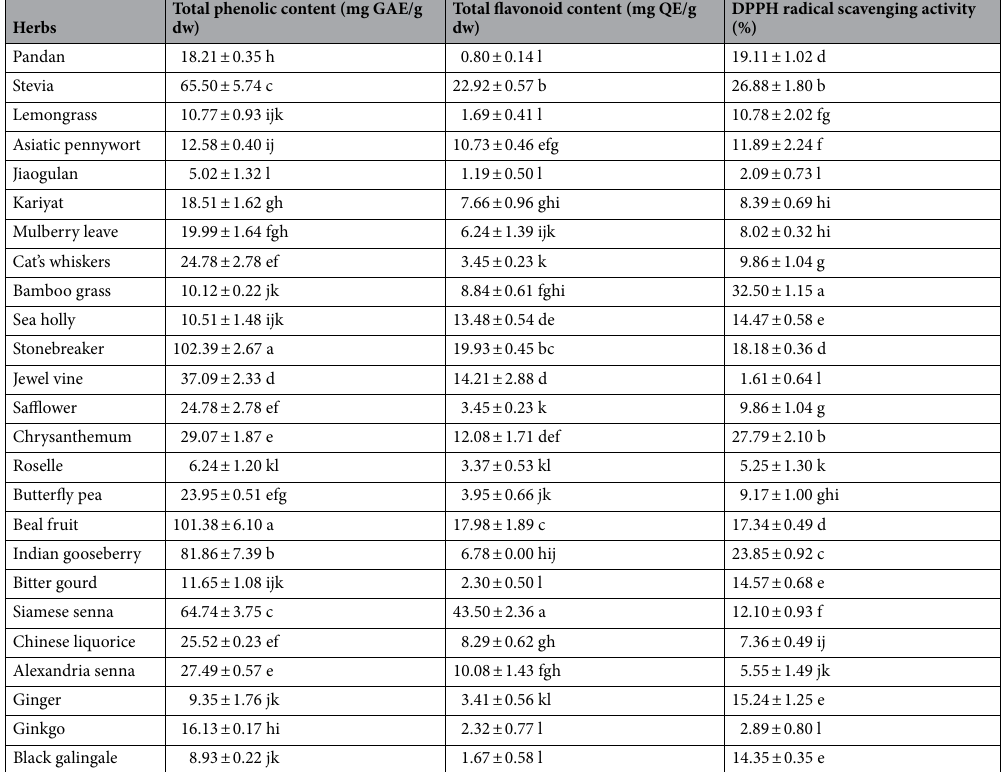
Table 3. Total phenolic content, total flavonoid content and DPPH scavenging activity in herbal tea extracts. Values are means ± SD of three measurements (n = 3). Means in columns with superscript letters indicate significant differences ( p <